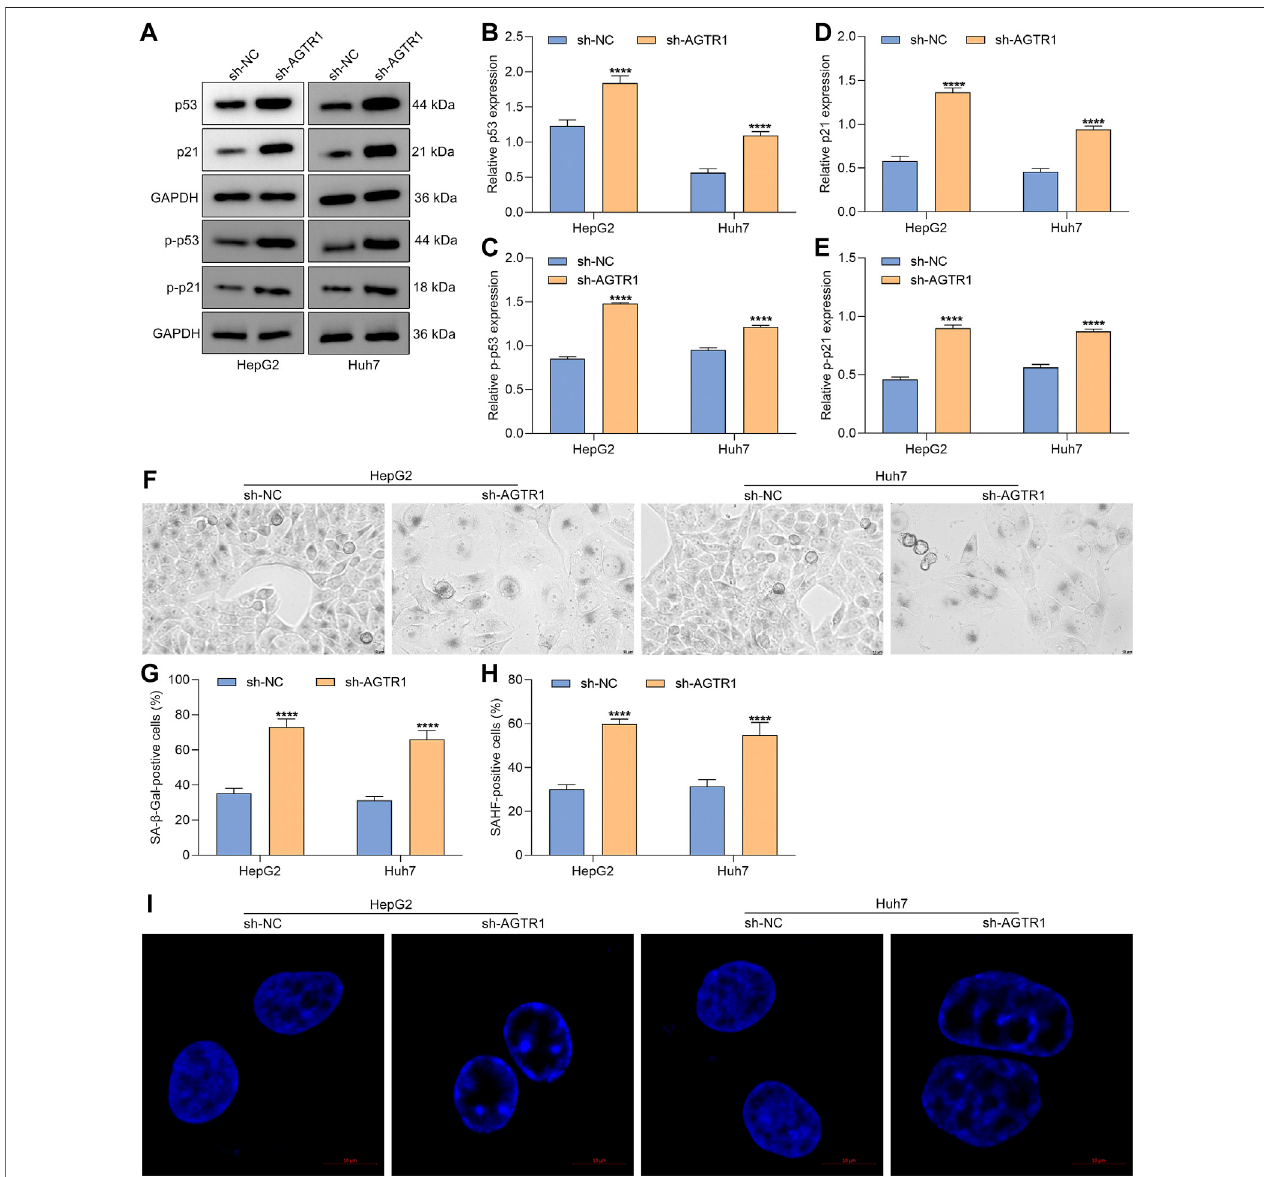
FIGURE2| SuppressionofAGTR1triggerscellularsenescenceofHCCcells via p53/p21signaling. (A – E) Expressionofp53,p-p53,p21,andp-p21inHepG2and Huh7 cell lines with sh-AGTR1 lentivirus transduction. (F,G) SA- β -Gal activity of HCC cell lines with sh-AGTR1 lentivirus transduction. Scale bar, 10 μ m. (H,I) SAHF activity of HCC cell lines with sh-AGTR1 lentivirus transduction. Scale bar, 10 μ m.